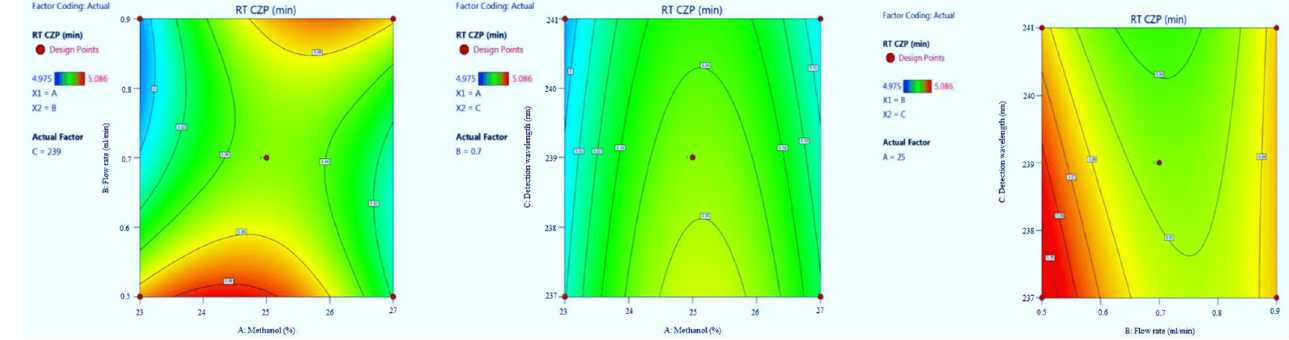
Figure 6. Contour plots for clonazepam (CZP) retention time in terms of AB, AC, and BC.